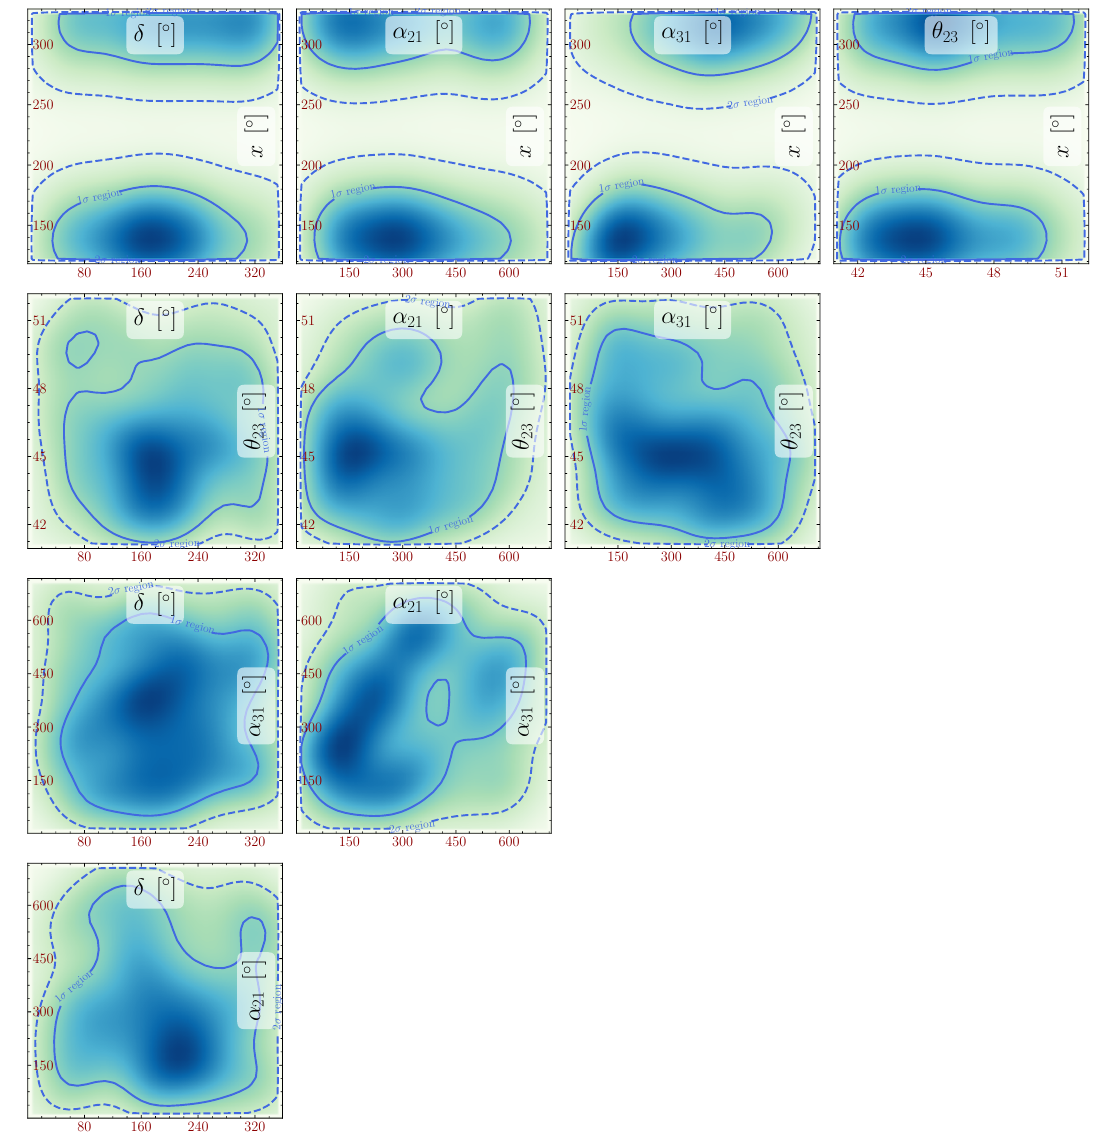
Figure 3 . The triangle plot shows regions of the model parameter space compatible with the measured (cid:17) B within 1 (cid:27) and 2 (cid:27) for a normally ordered mass spectrum using resonant leptogenesis with M = 1 : 2 10 6 GeV. The (cid:12)xed parameters were set to be y = 190 : 22 (cid:14) , (cid:18) 12 = 33 : 63 (cid:14) and (cid:2) (cid:18) 13 = 8 : 51 (cid:14)